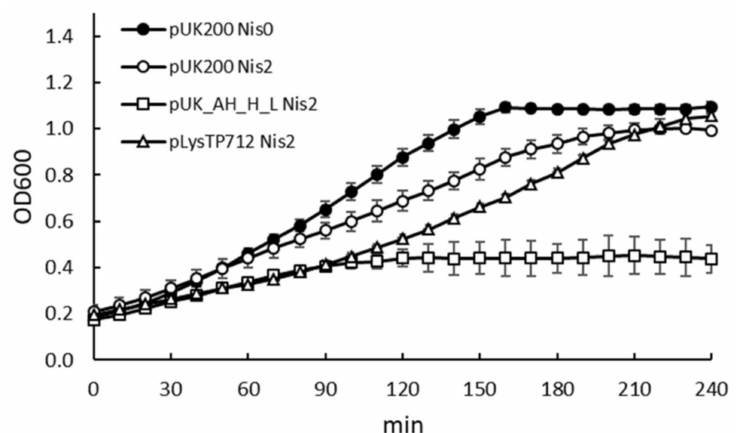
Figure 2. Growth of L. lactis NZ9000 expressing TP712 phage lytic genes. Gene expression was